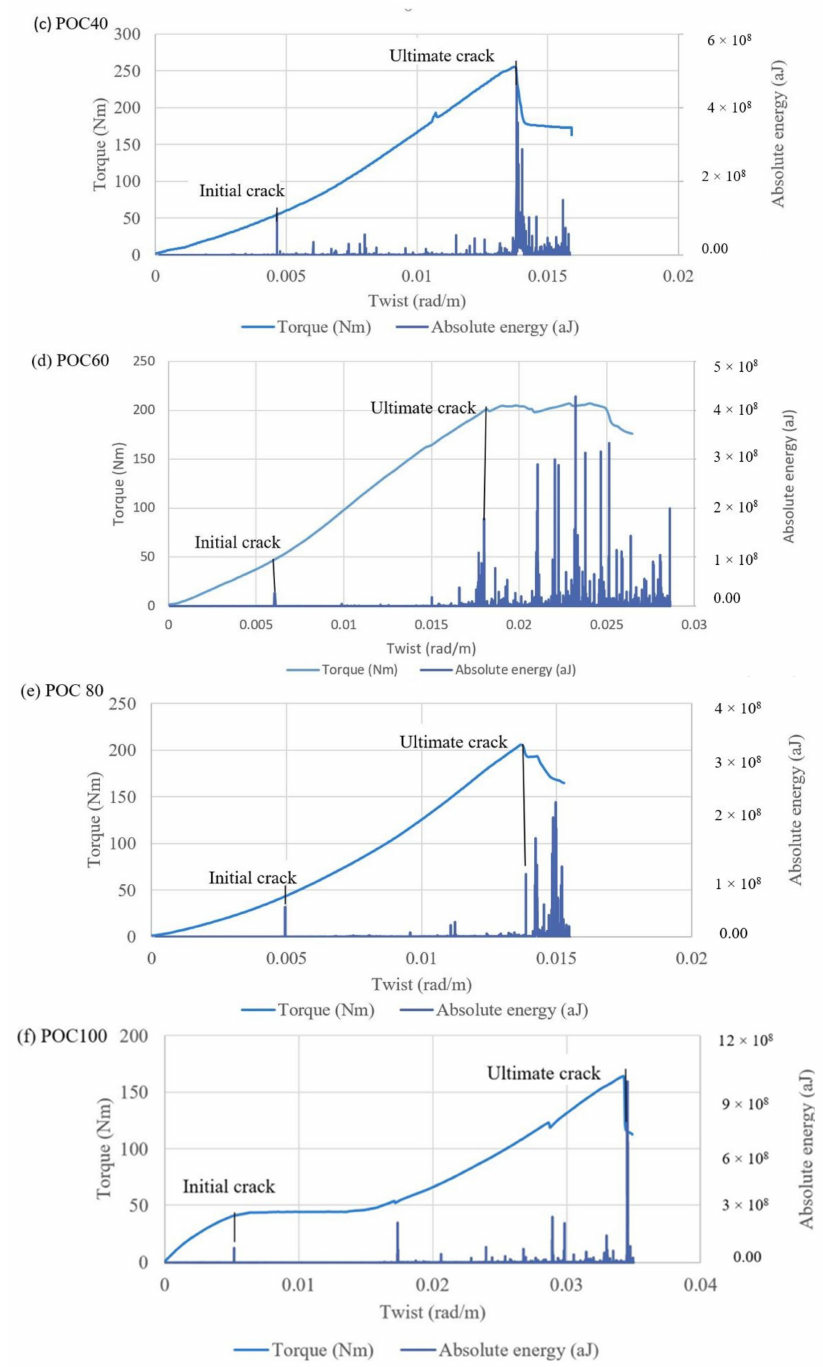
Figure 7. Absolute energy and torque versus angle of twist graphs for ( a ) 0%, ( b ) 20%, ( c ) 40%, ( d ) 60%, ( e ) 80%, and ( f ) 100% replacement levels of POC coarse aggregate. The ultimate twist decreased upon increasing the POC ratio from 0 to 40%. Beyond a 40% ratio of POC, the specimens had an increase in the ultimate twist. A large ultimate twist of 0.039 and 0.034 rad/m, was observed for POC0 and POC100 specimens, respectively. This indicates that POC0 and POC100 specimens have high resistance to ultimate cracks due to homogeneity and the existence of a single type of coarse aggregate (i.e., 100% of granite or 100% of POC). However, POC100 specimens resist the lowest torque, while POC0 specimens exhibit the maximum ultimate toque. This can be attributed to the low impact and crushing strength of the POC aggregates as compared to